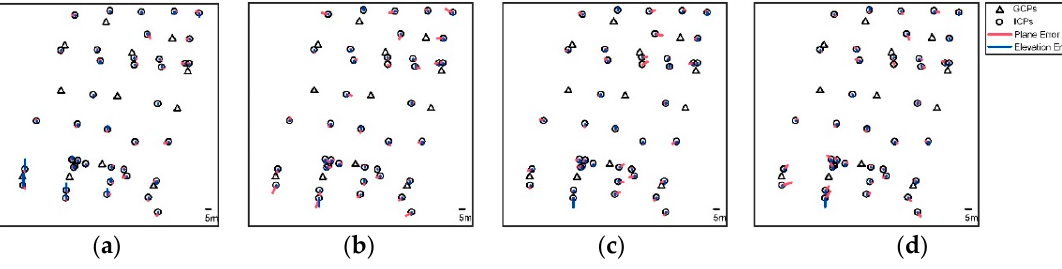
Figure 4. Residual distributions of ICPs of controlled network adjustment for the Songshan area: ( a )